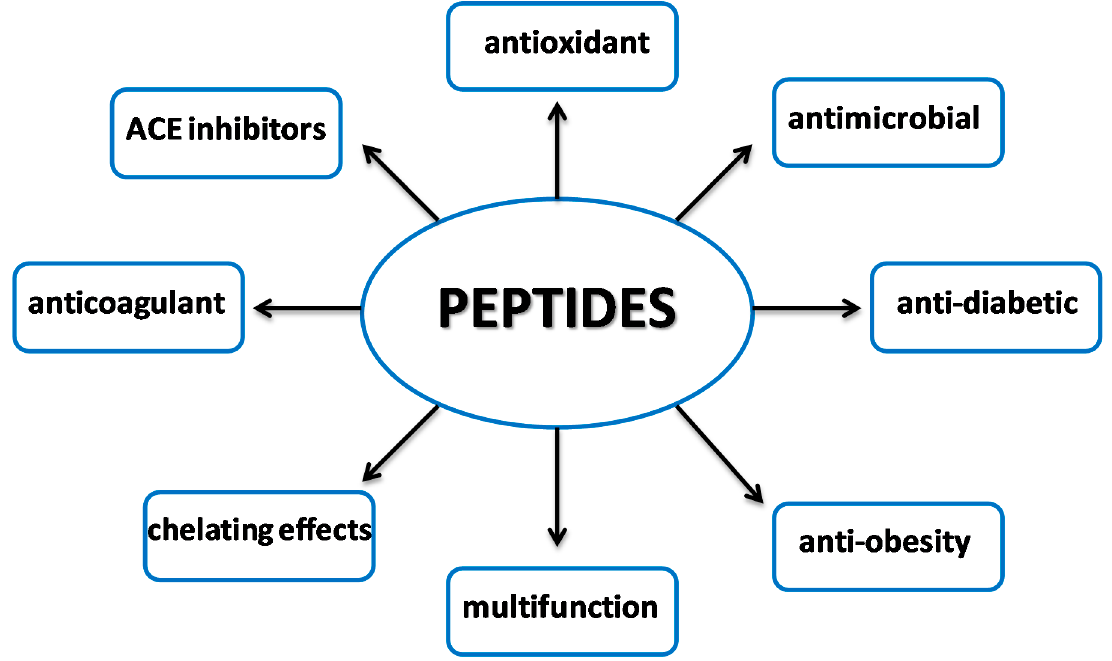
Figure 2. Properties of bioactive peptides.